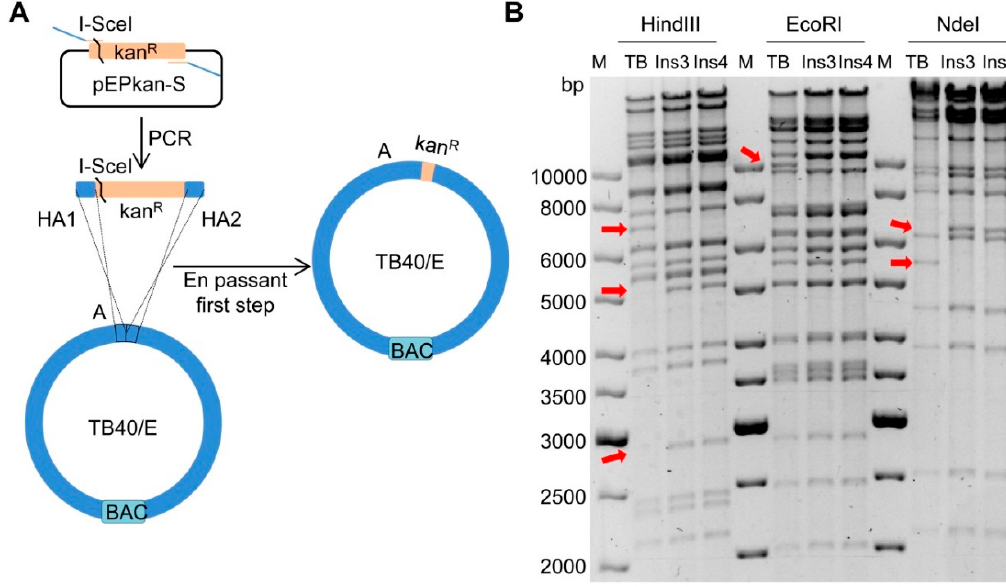
Figure 2. Insertion of a kan R /I-SceI cassette into fragment A of TB40/E. ( A ) Schematic view of the insertion strategy (first step of en passant mutagenesis). The kan R /I-SceI cassette was PCR-amplified using plasmid pEPKan-S as a template and primers containing homology arms (HA) homologous to the target sequences in fragment ‘A’. The purified PCR product was transformed into competent GS1783 carrying the TB40/E BAC. Recombinant BAC clones were selected by chloramphenicol and kanamycin. ( B ) BAC DNAs of two clones (Ins3 and Ins4) were analyzed by restriction digestion with HindIII, EcoRI, and NdeI, respectively. Arrows indicate the expected alterations caused by the insertion of the kan R /I-SceI cassette compared to the parental TB40/E genome (TB).